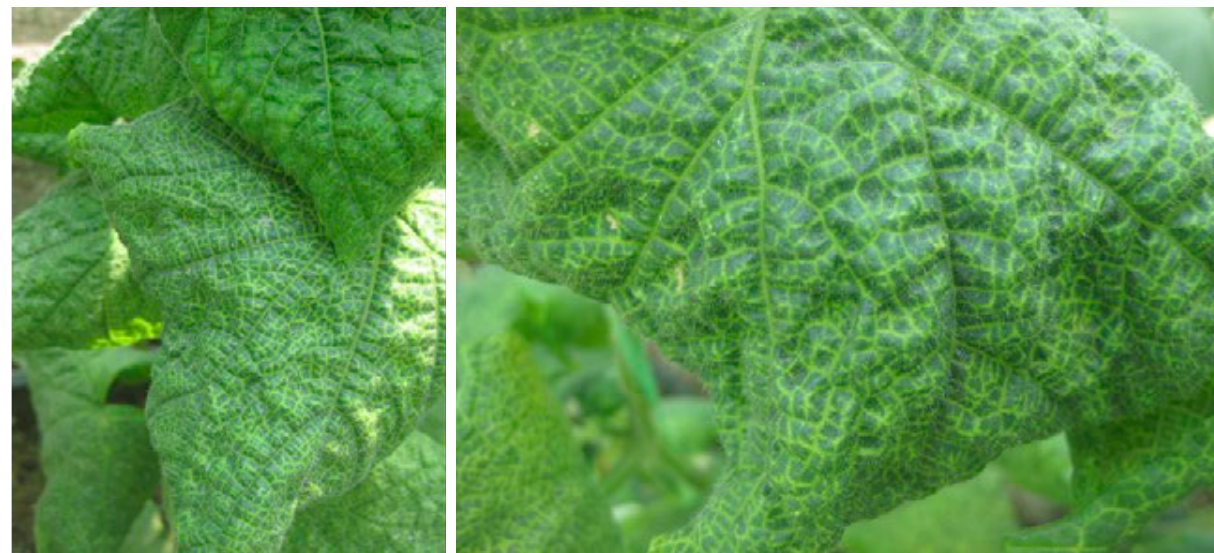
Figure 1. Severe vein clearing symptom in greenhouse-grown cucumber plants naturally infected with Cucumber vein yel- lowing virus in Tehran (Varamin),